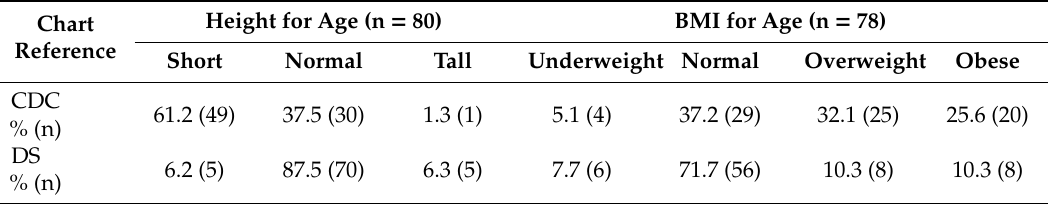
Table 2. Distribution of participants according to height-for-age (n = 80) and BMI-for-age percentile growth charts (n = 78).